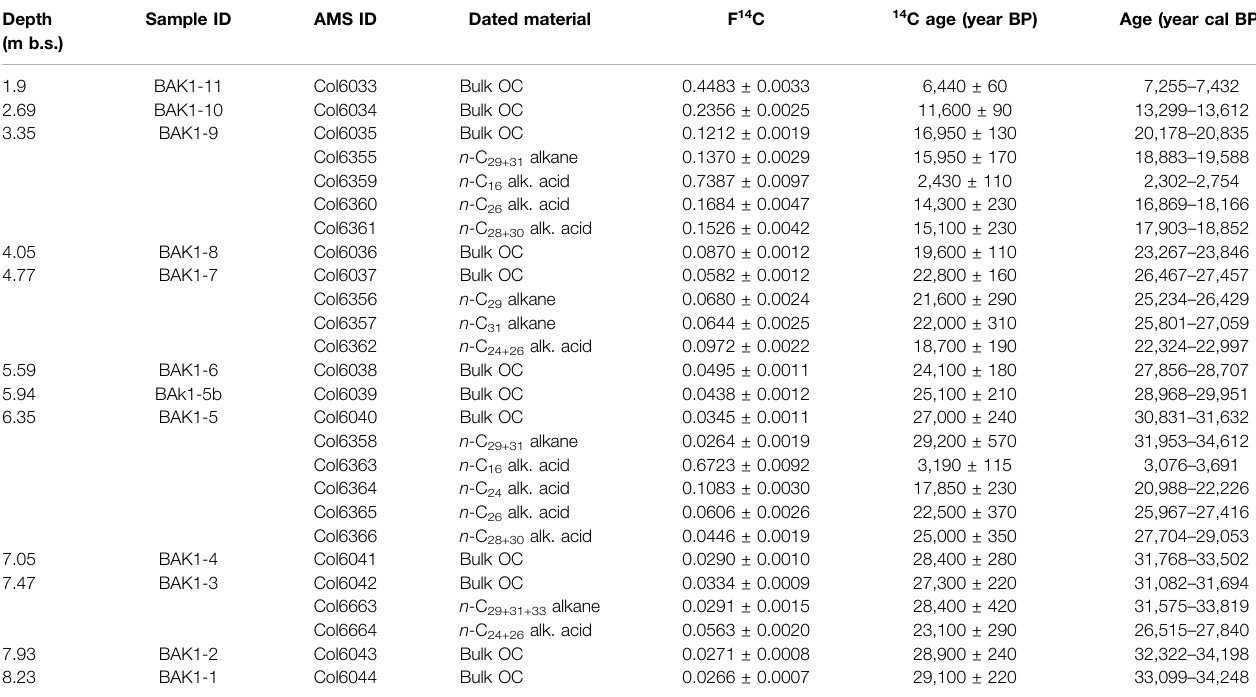
TABLE 2 | Radiocarbon isotope data and ages obtained on bulk organic carbon (bulk OC) and n -alkanes and n -alkanoic acids (alk. acids). Calibrated ages are given as 2 σ uncertainty ranges. Depth (m